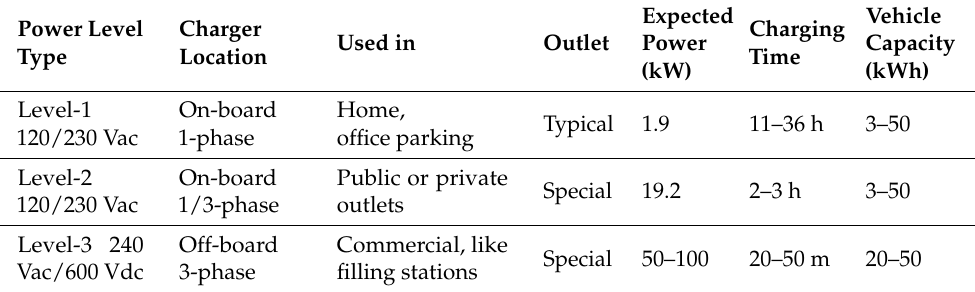
Table 1. EV battery charger levels